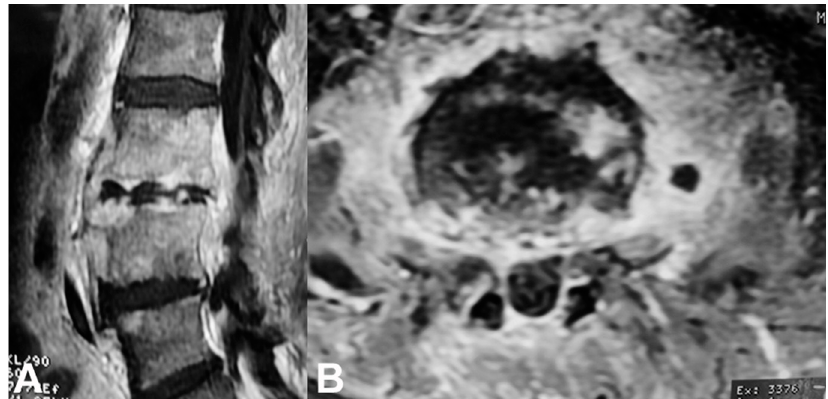
Figure 4. A 62-year-old man with L3-L4 MRSA spondylitis a couple of weeks after an infected olecranon bursitis. ( A ) Sagittal and ( B ) axial MR imaging show extensive destruction of the L3 and L4 vertebrae and abscess formation extending to the spinal canal. He was treated with surgical decompression and abscess drainage followed by a 6-month antibiotics regimen. Table 3. Indications for surgical treatment.